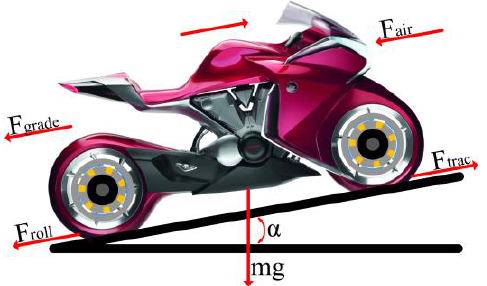
Figure 23. Dynamic traction forces of E-Motorcycle (Honda concept).